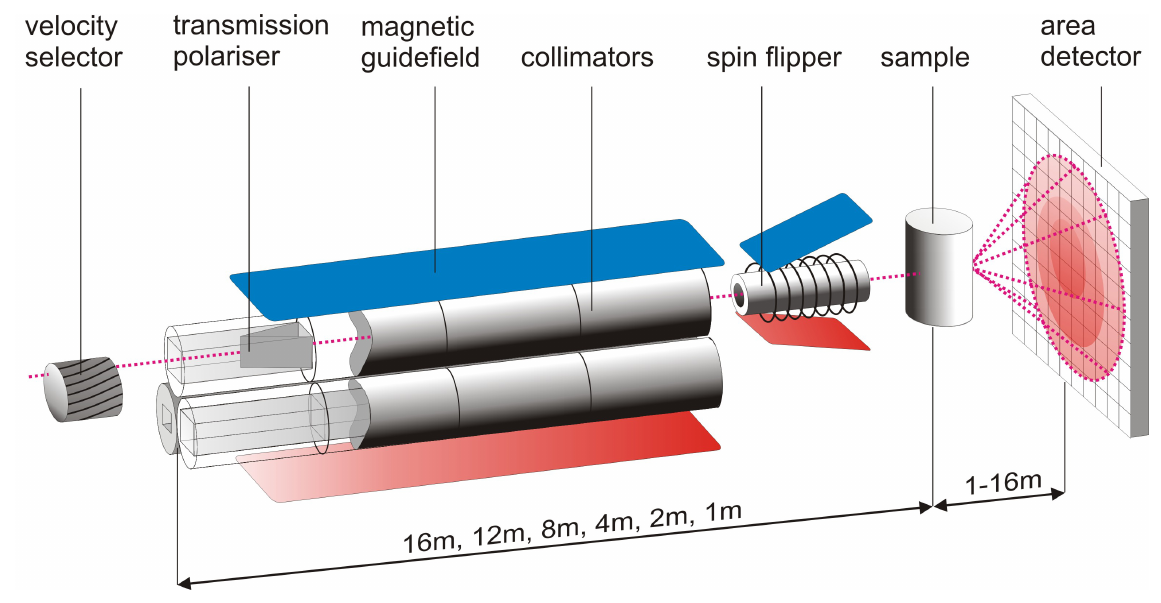
Figure 2: Schematic view of